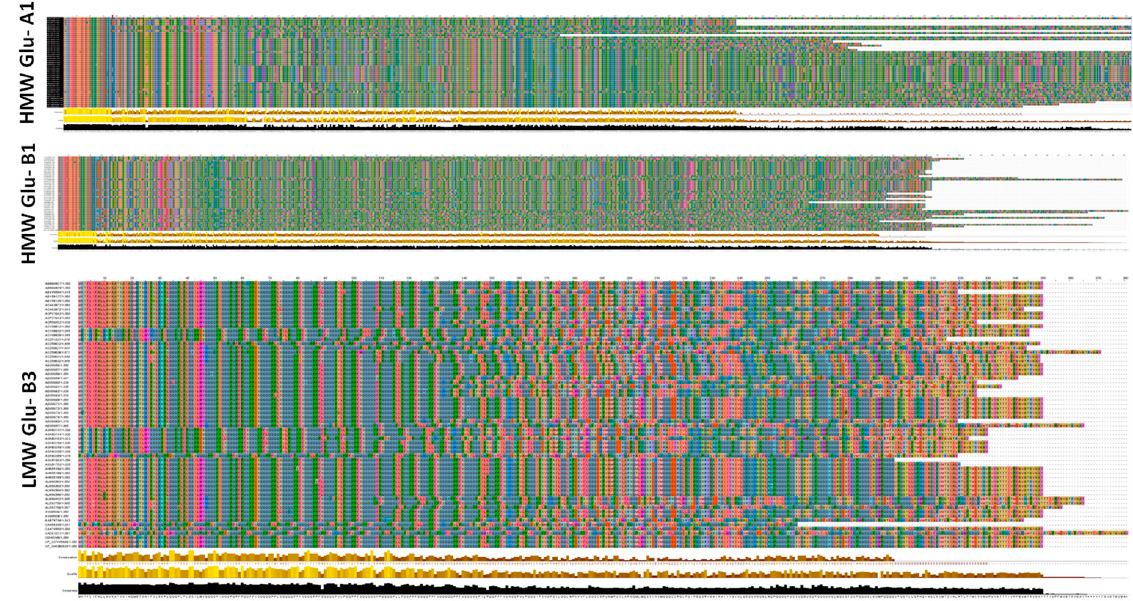
Figure 5. Multiple amino acid sequence alignments of HMWGS Glu-A1, Glu-B1, and Glu-B3 of durum wheat, bread wheat, and their relative species.